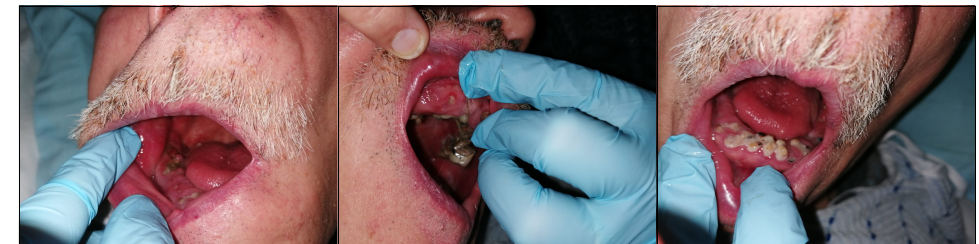
Figure 5. An anonymized real case study. Although no hospital examination was necessary, this example points out the effectiveness of the proposed